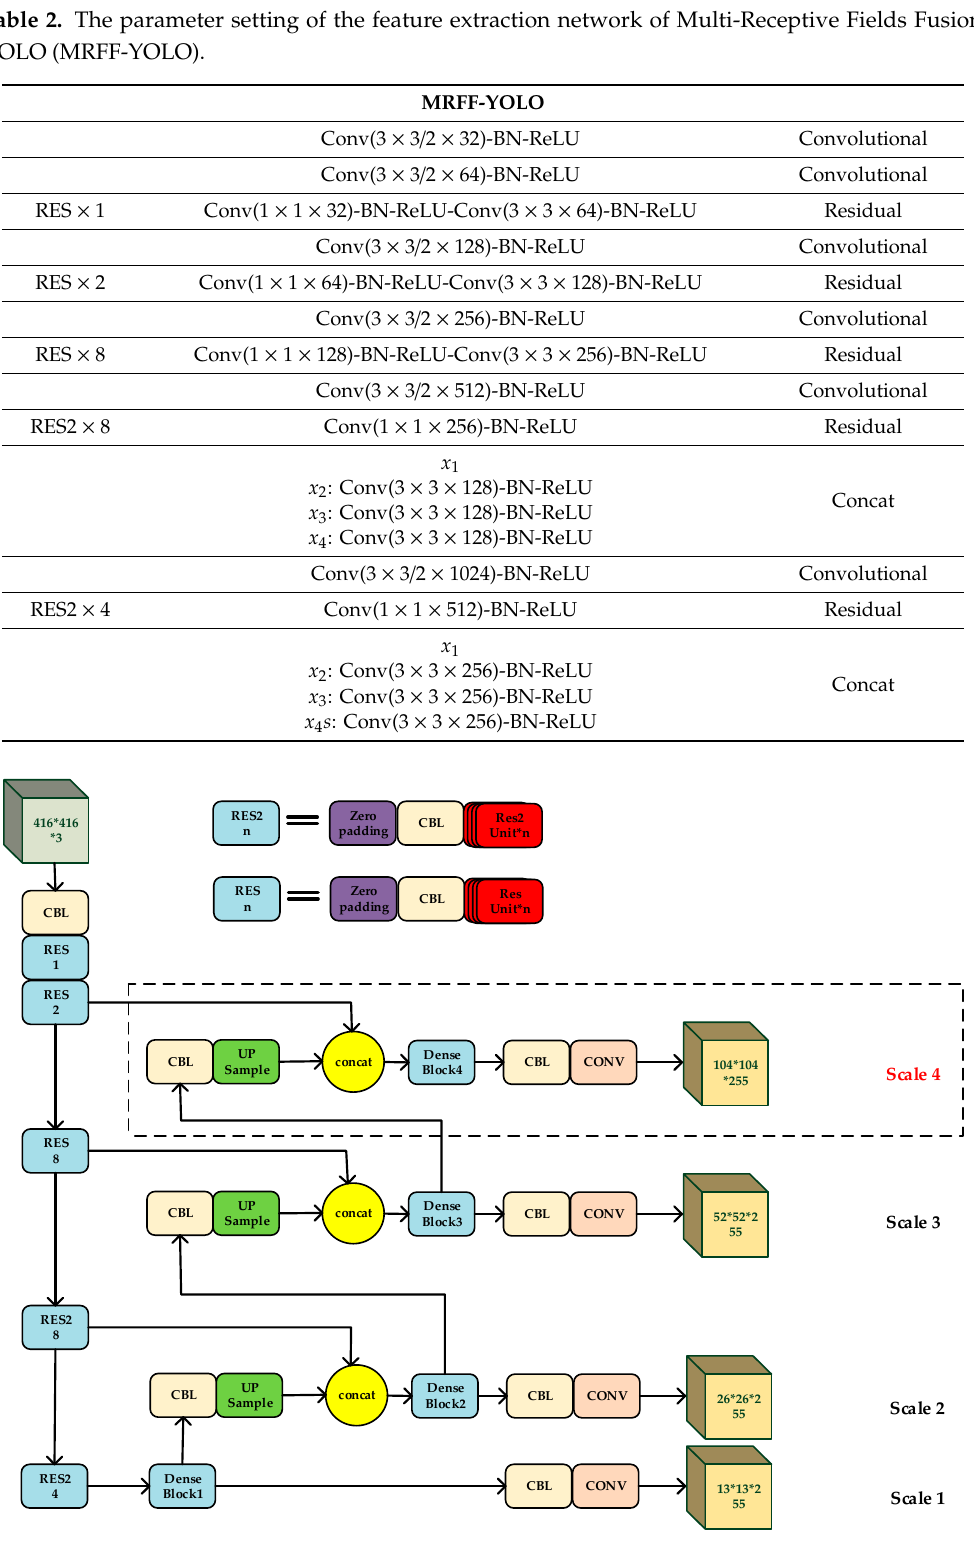
Figure 5. The structure of the proposed network.